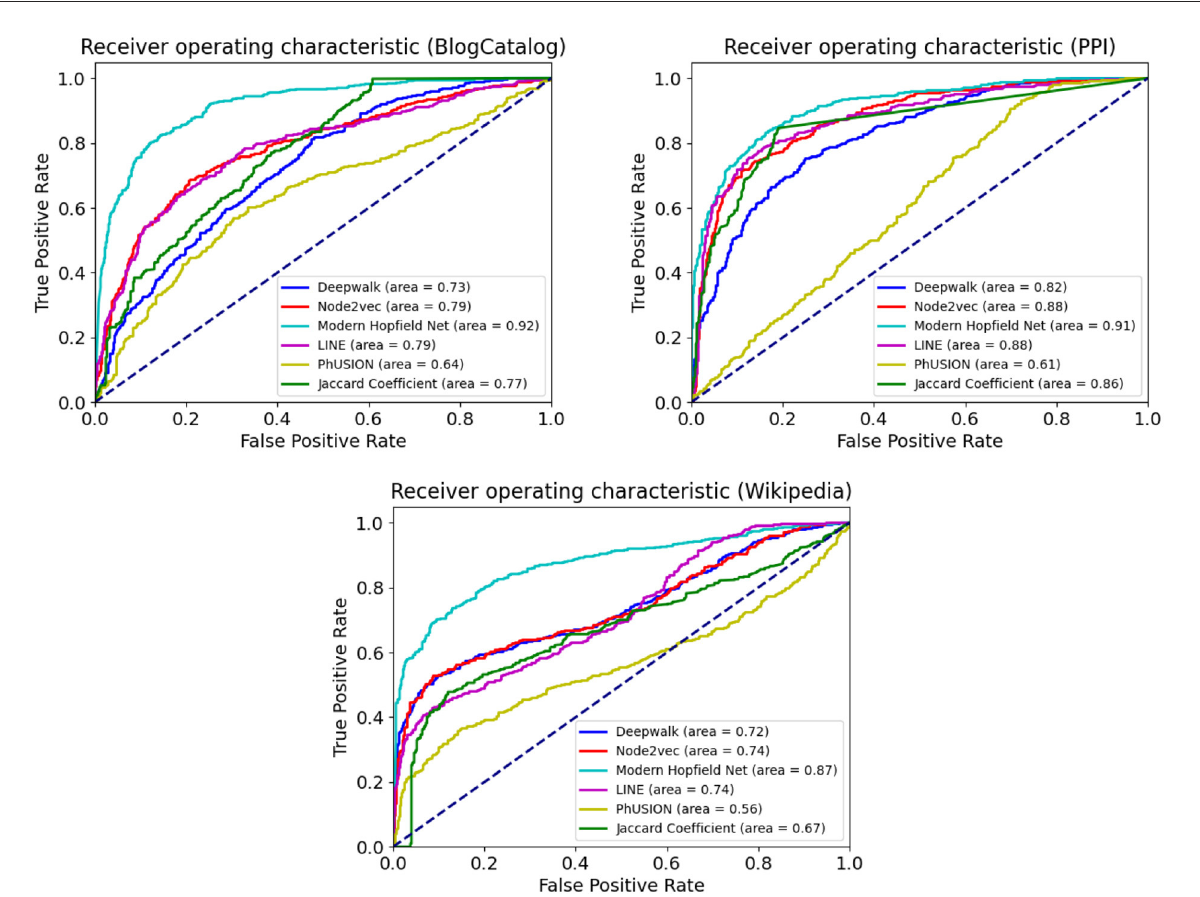
FIGURE3 The Receiver Operating Characteristic (ROC) curve for the link prediction task on BlogCatalog, PPI, and Wikipedia. Comparison with popular baseline